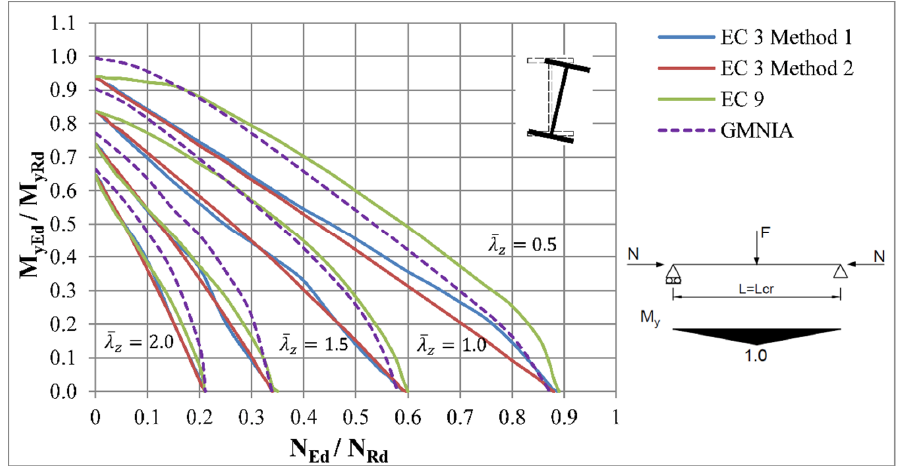
Figure 24. Interaction curves for laterally unrestrained beam-columns with IPE 100 cross-section with free